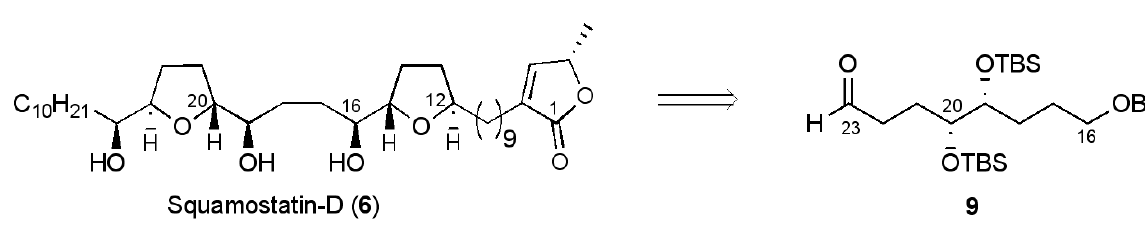
Figure 6. Marshall’s approach to squamostatin-D ( 6